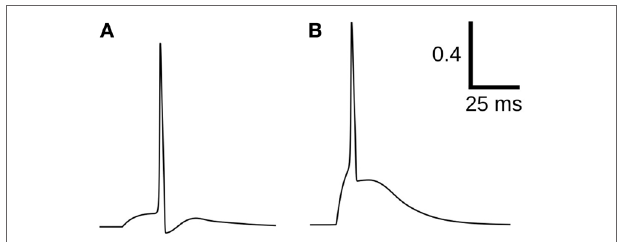
FIgURe 12 | Comparison of convexity evaluation for C 20,0.6 and C line . For (A) : C line = 0.23, C 20,0.6 = − 4.78; for (B) : C line = 0.16, C 20,0.6 = −